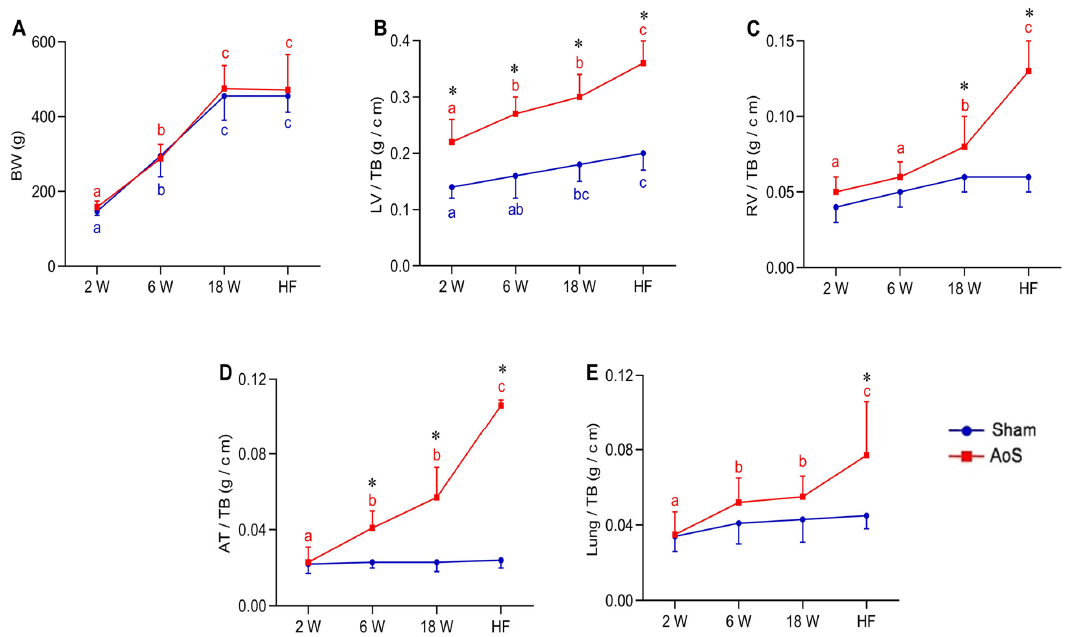
Figure 1. Bodyweight and post mortem cardiac morphology at different euthanasia moments (2, 6, 18 weeks [W] and heart failure [HF]). Sham: operated control (blue); AoS: supravalvar aortic stenosis (red). ( A ) BW: body weight. ( B ) LV/TB: left ventricle corrected by tibia (TB). ( C ) RV/TB: right ventricle corrected by TB; ( D ) AT/TB: atrium corrected by TB; ( E ) Lung/TB: lung corrected by TB. Data are expressed as mean ± SD and analyzed by ANOVA and Tukey. p < 0.05. * AoS vs. respective Sham. Distinct letters signify statistical difference between moments ( n = 12–18 animals for each group).